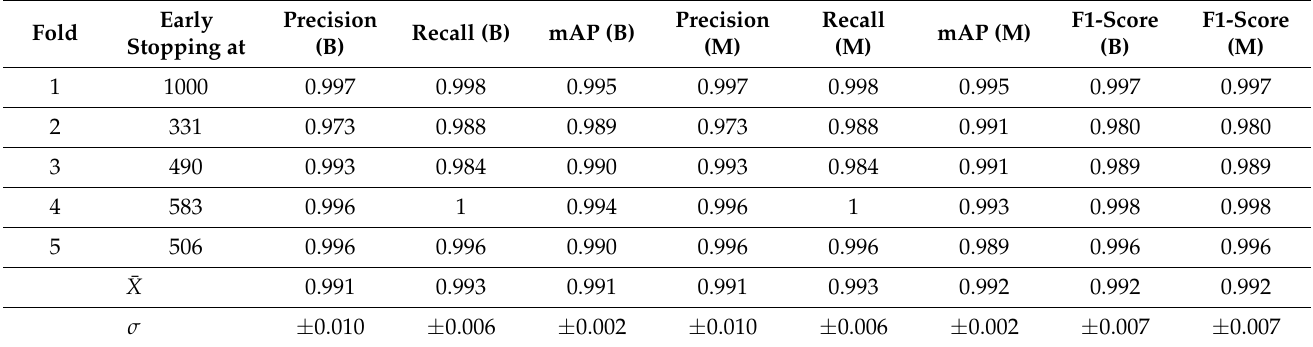
Table 7. Results for YOLOv5 medium model.